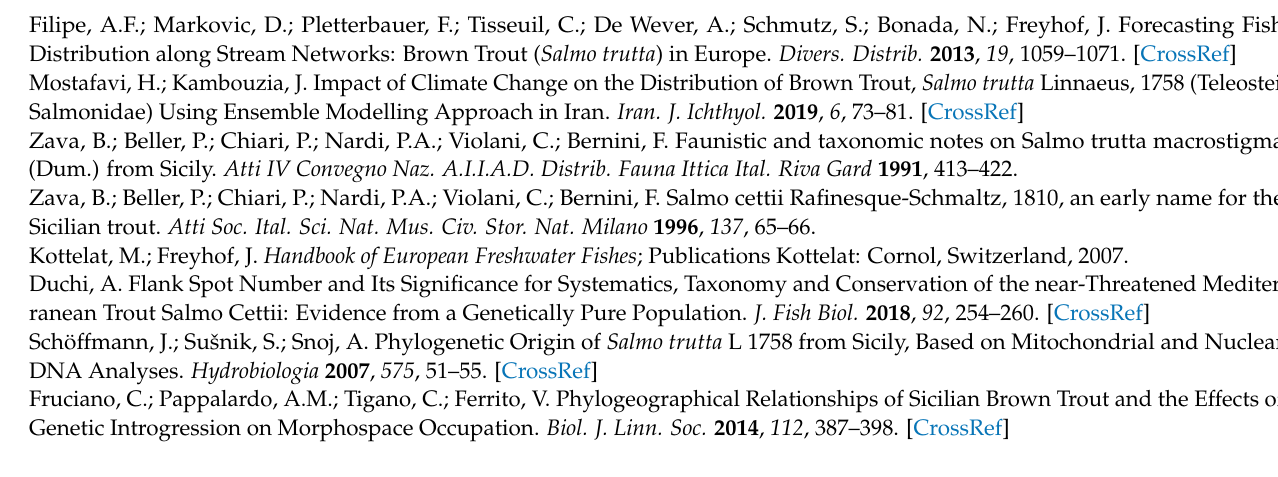
Table S1: Hatchery origin of specimens from the Irminio and San Leonardo Rivers according to genet- ics (presence of the exogenous hatchery allele LDH-C*90 ) and morphology [6]. In bold, individuals of pure hatchery or hybrid origin according to genetics or morphology. Discrepancies between the two methods are shaded in